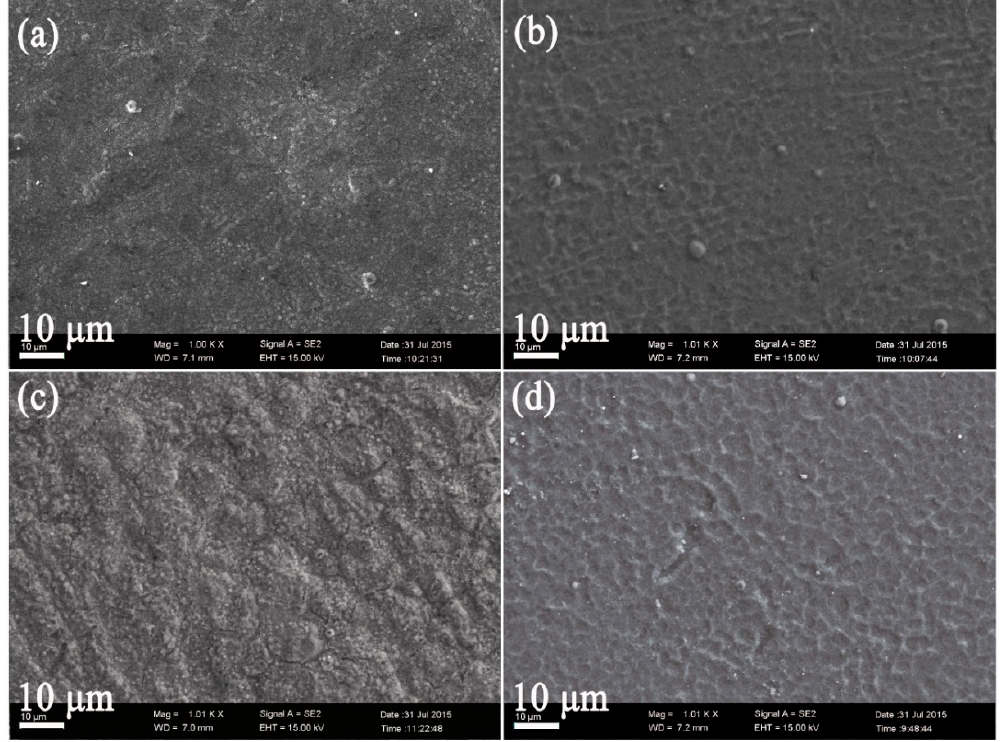
Figure 3. Typical SEM images showing surface morphologies of the ( a and c ) untreated and ( b and d ) USRP Ti plasma-nitrided at ( a and b )750 °C and ( b and d ) 850 °C.